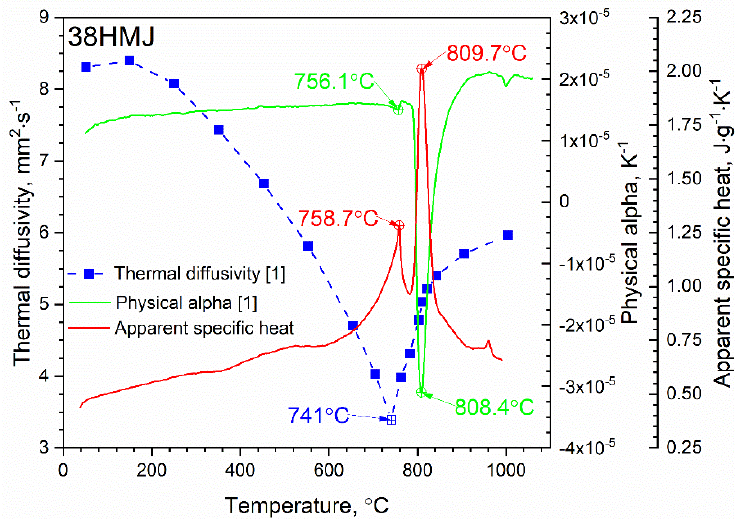
ff usivity, physical alpha, and apparent specific heat of 38HMJ barrel Figure 9. Thermal diffusivity, physical alpha, and apparent specific heat of 38HMJ barrel steel. Figure 9. Thermal di